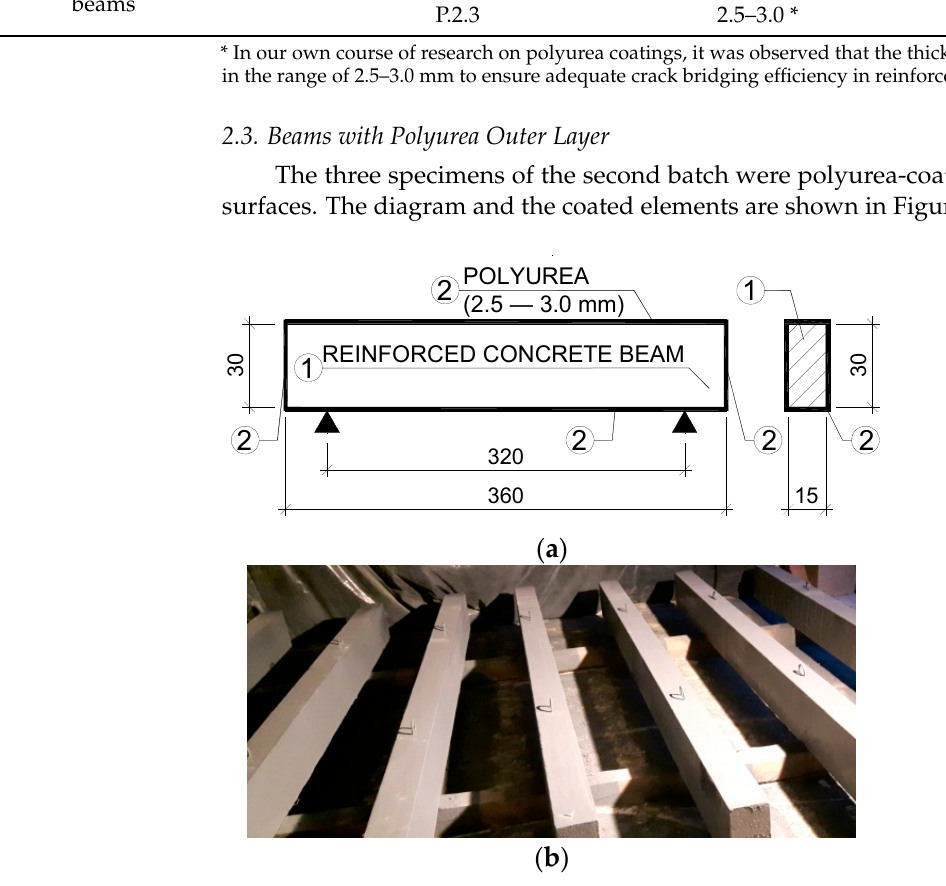
Figure 3. The arrangement of rebars for the RC beams before concreting.